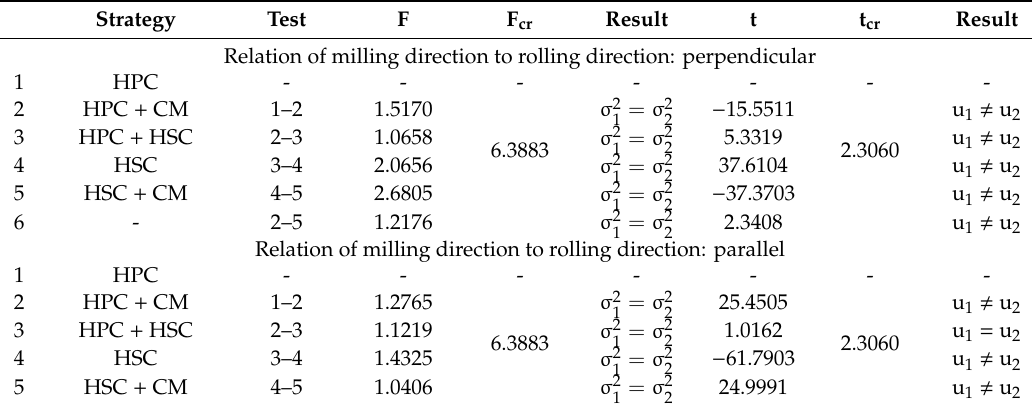
Table 8. Statistical verification of the results of relative deformations ε ( α = 0.05)—with textured surface layer removal